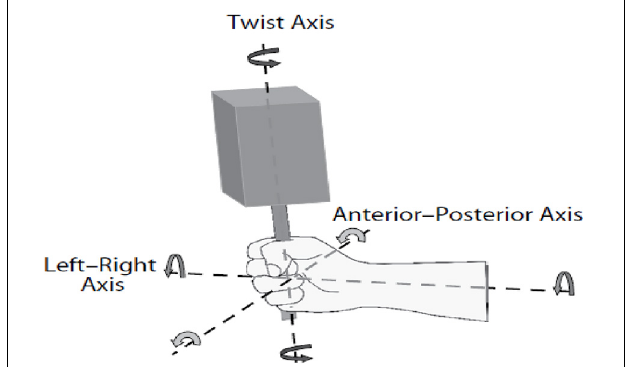
FIGURE 2 | Type of objects used in the experiments by Arzamarski et al. (2010) with the relevant axes of rotation. Figure 8 from Arzamarski et al. (2010).